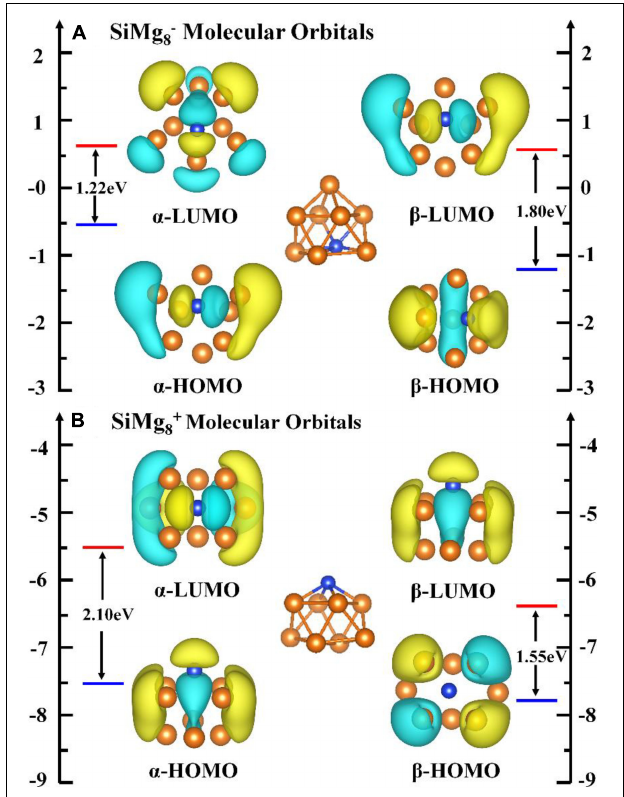
FIGURE 6 | Molecular orbitals (MOs) of the most stable clusters of panels (A) SiMg − 8 and (B) SiMg + 8